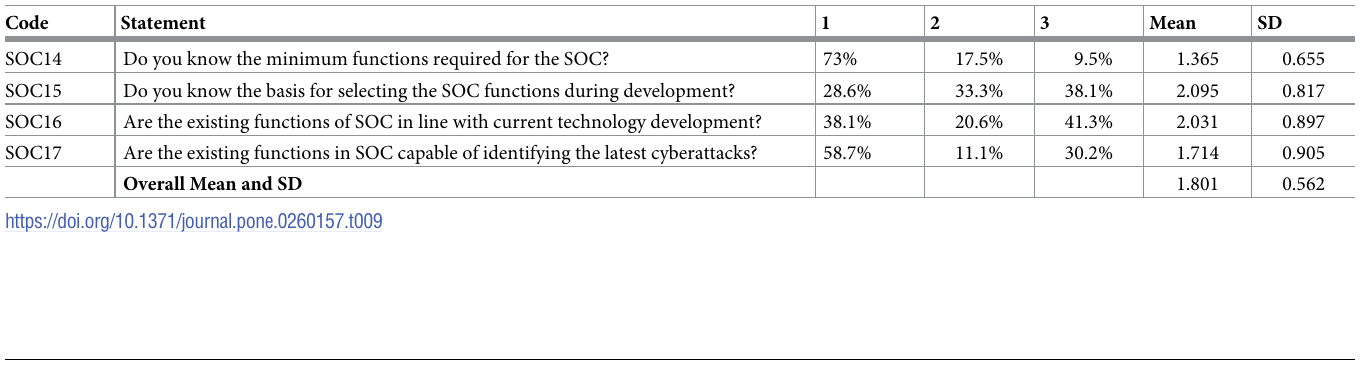
Table 9. Knowledge on the functions of SOC among the respondents.